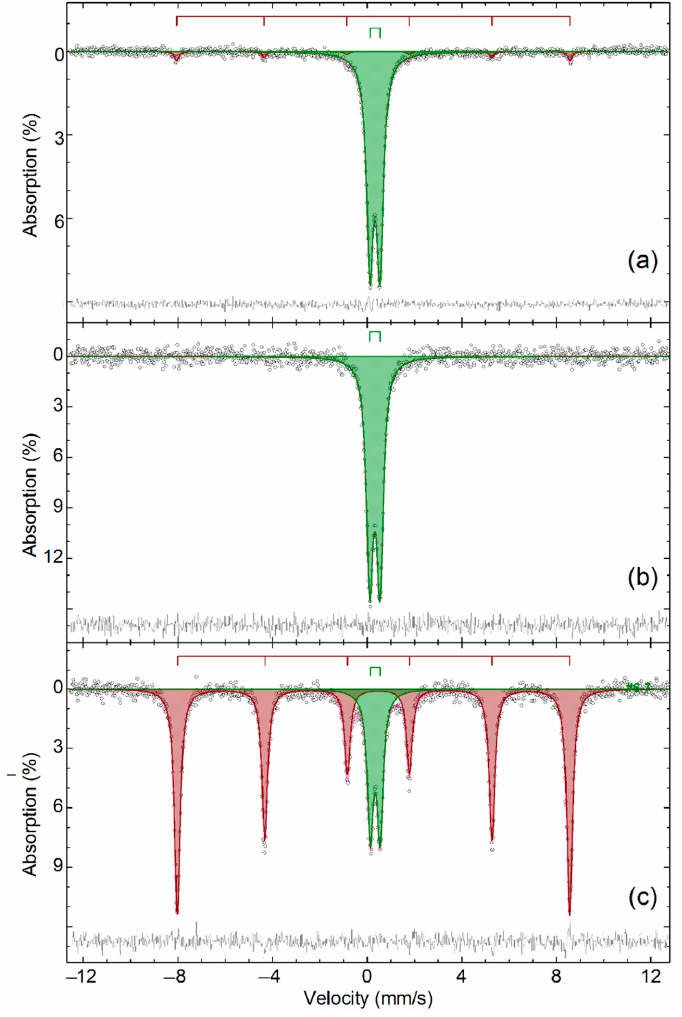
Figure A5. The Mössbauer spectra obtained at 296 K of ZPR roasted: ( a ) without additions at 600 °C; ( b ) with addition of 48% Fe 2 (SO 4 ) 3 at 600 °C, then additionally calcined at 900 °C; ( c ) with addition of 48% Fe 2 (SO 4 ) 3 at 600 °C, water-leached, then additionally calcined at 900 °C.